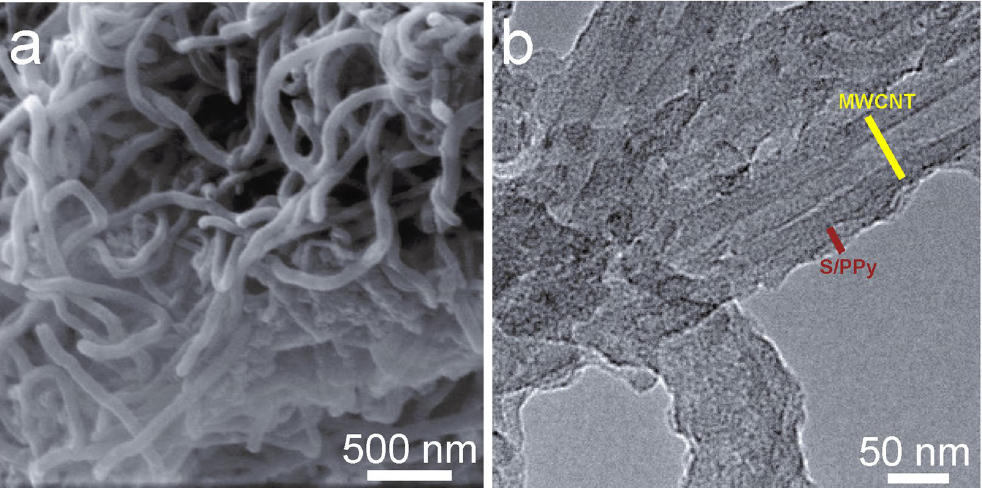
Figure 2. ( a ) SEM and ( b ) TEM images of the MWCNTs/S/PPy composites.